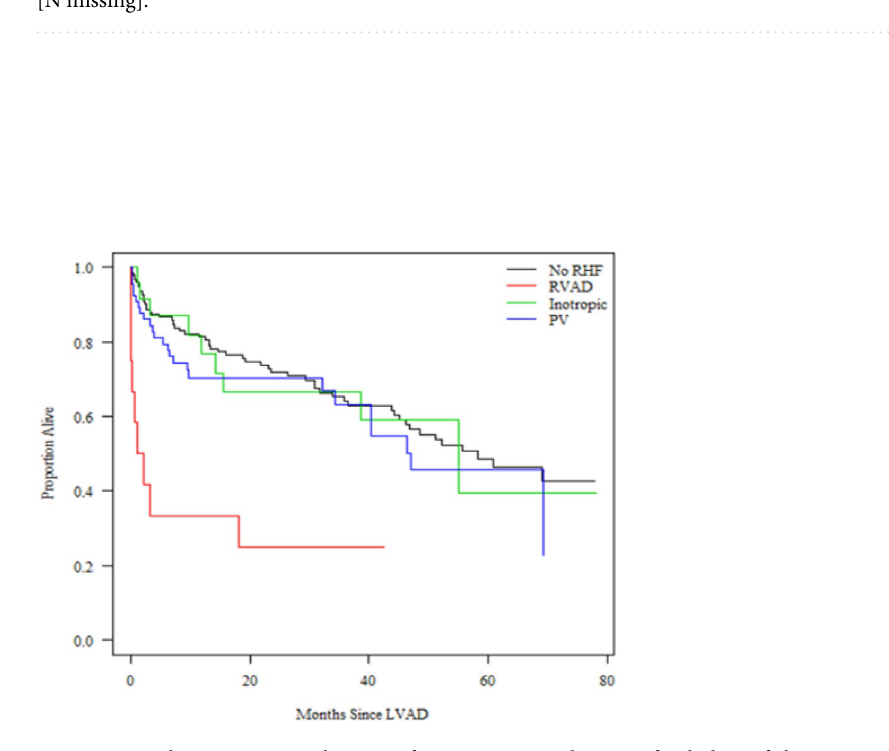
Figure 1. Kaplan Meier survival curves of LVAD recipients by type of right heart failure. RHF: right ventricular heart failure, RVAD: right ventricular assist device within 30 days, Inotropic: Inotrope Use > 14 days after LVAD, PV: pulmonary vasodilator Use > 48